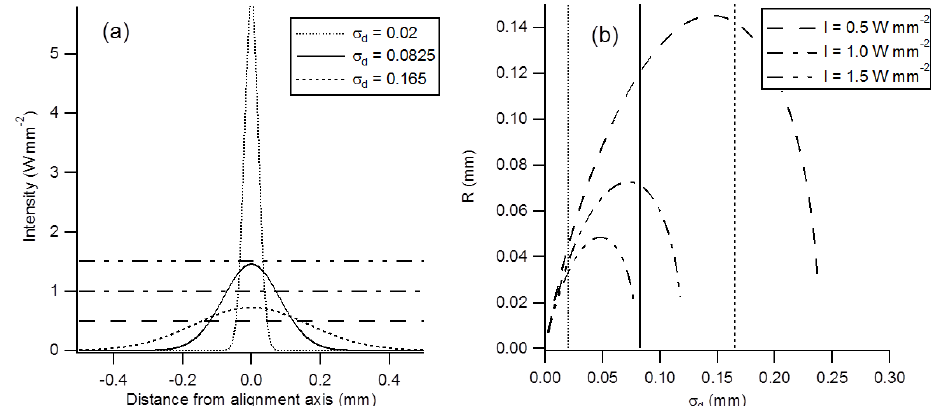
Figure 4. (a) Gaussian intensity distribution for collimated laser beams of fixed power focussed to detection beam width ( σ d ) of 0.02, 0.0825, and 0.165. (b) The relationship of the effective detection radius ( R ) with respect to detection beam width (σ detect ) for I min of 0.5, 1.0, and 1.5Wmm − 2 . The beam widths shown in the left panel are marked for reference.